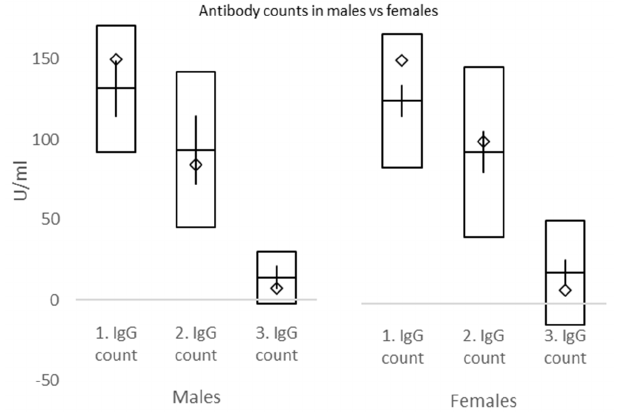
Figure 5. Difference of IgG counts between gender (71 females and 23 males for each IgG measure- ment) □ mean ± standard deviation; ◊ median; │ minimum − maximum.